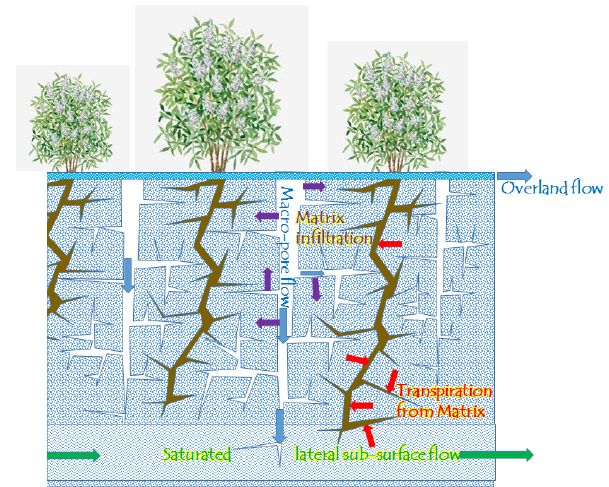
Figure 4. Perceptual model of water flow pathways in the critical zone.